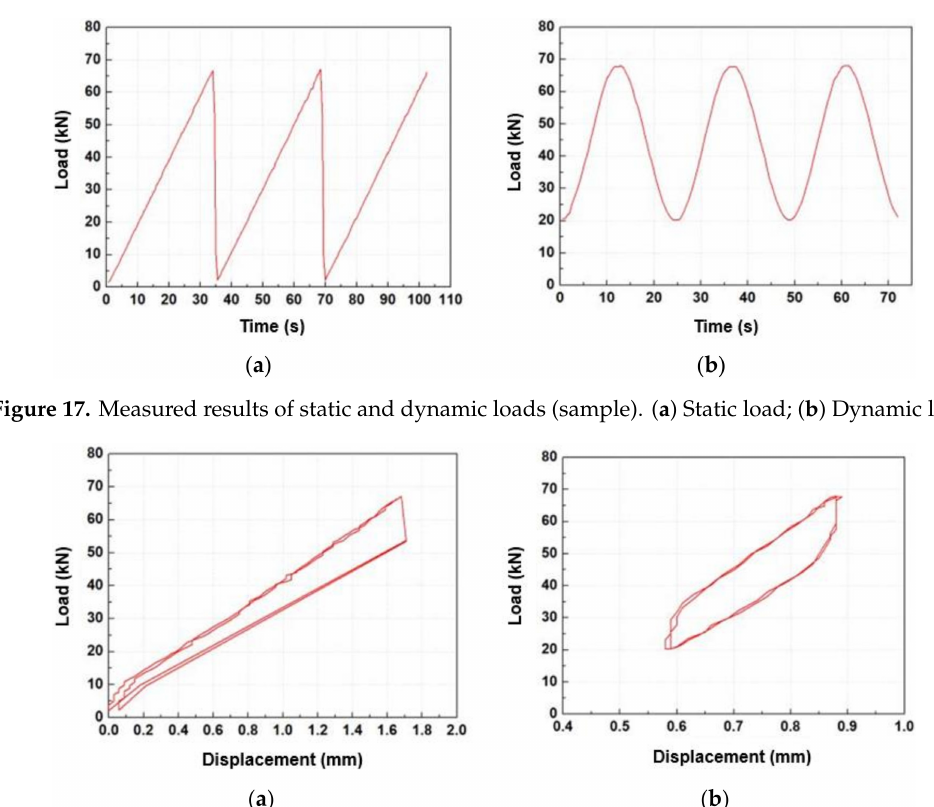
Figure 18. Measured results of the load–displacement curve. ( a ) Static; ( b )